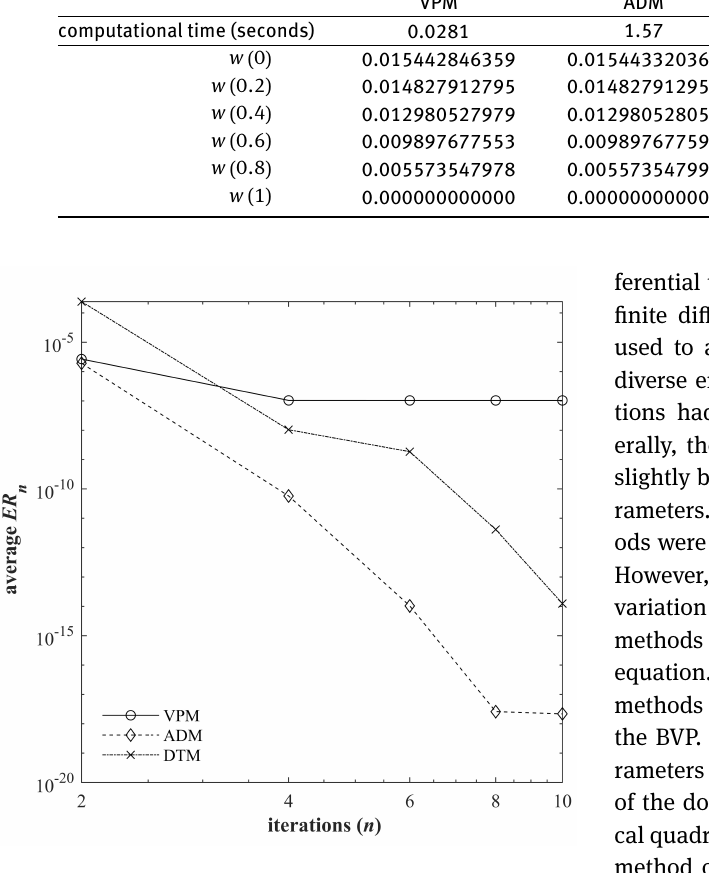
Fig. 7: Comparison of the average error remainder as a function of iteration for the approximate solutions of equation (40) using VPM, ADM, and